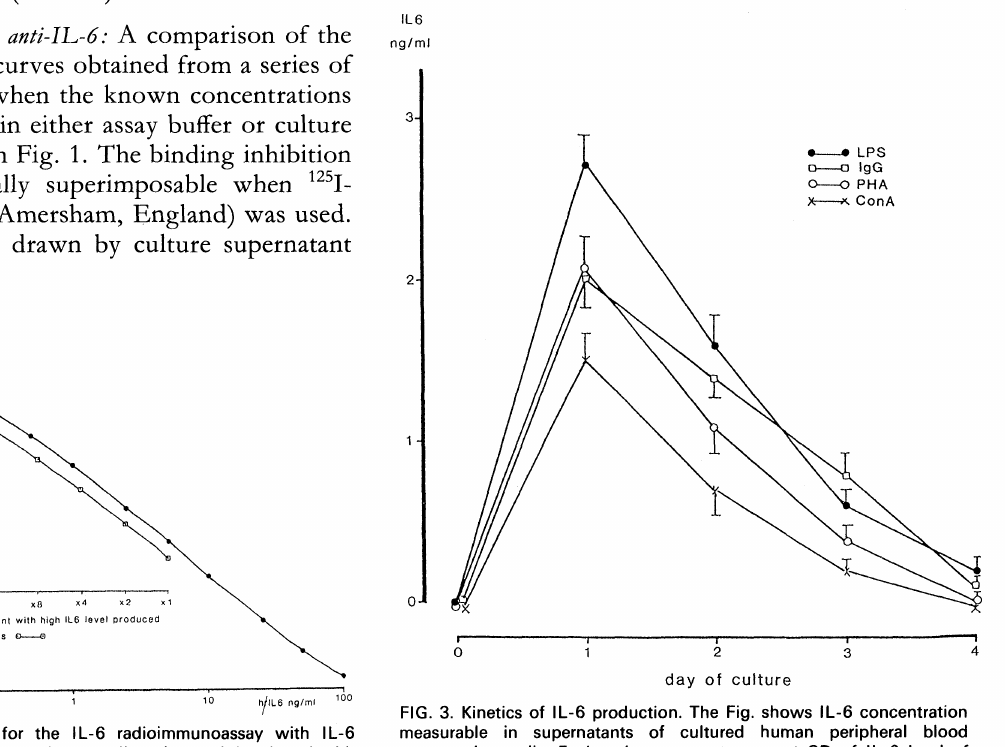
FIG. 1. Standard curves for the IL-6 radioimmunoassay with 11_-6 standards diluted in buffer or culture medium (O--O) incubated with 1251-recombinant IL-6 and dilution curve by supernatant medium with high 11_-6 concentration produced by stimulating human peripheral blood mononuclear cells ([]--I).